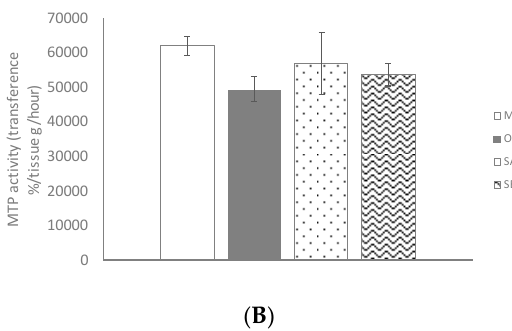
Figure 4. Effects on triacylglycerol re-esterification and triacylglycerol release of MetS rats (MS, n = 10), rats fed with wheat control diet (WC, n = 10), wheat and oat control diet (OC, n = 10), A snack (SA, n = 10), and B snack (SB, n = 10). ( A ) triacylglycerol re-esterification involved genes mRNA levels and ( B ) MTP activity. Values are expressed as mean ± SEM. Values not sharing a common letter are significantly different ( p < 0.05).